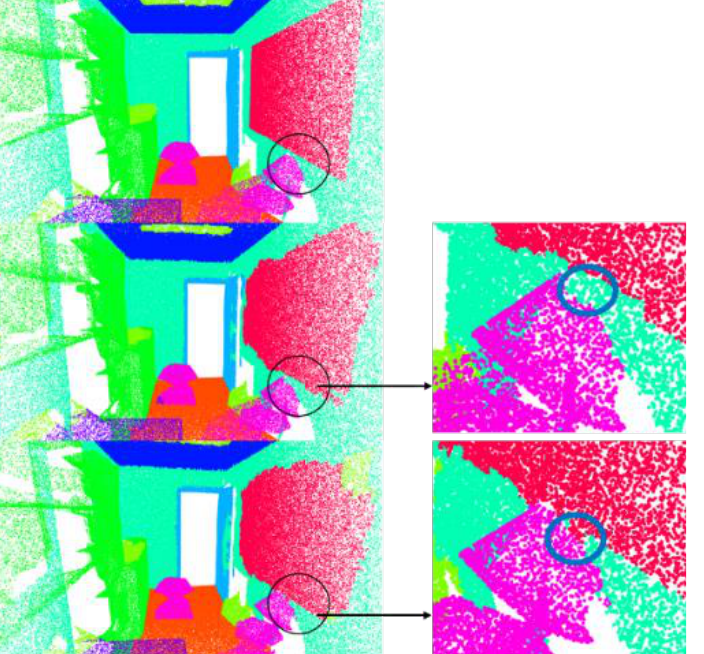
Figure 14. Visualization results. First row is the ground truth. Second row shows the results when using cross-skip selection. The third row shows the results when not using cross-skip selection.